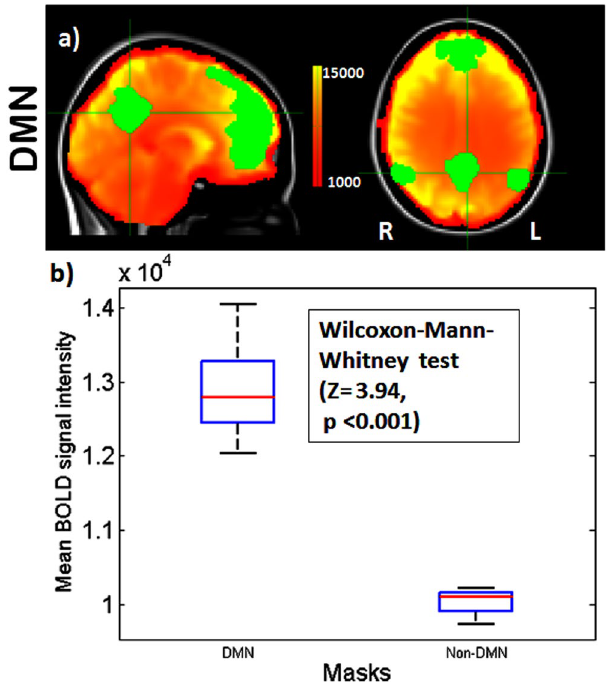
Figure 3. fMRI BOLD signal within the DMN and Non-DMN. ( a ) Resting state mean BOLD image of an exemplary subject with DMN mask identified by ICA overlaid on MNI 152 atlas (upper row). ( b ) The box plot shows the mean BOLD signal in within the DMN and non-DMN mask. During rest the BOLD signal is significantly higher in the DMN than